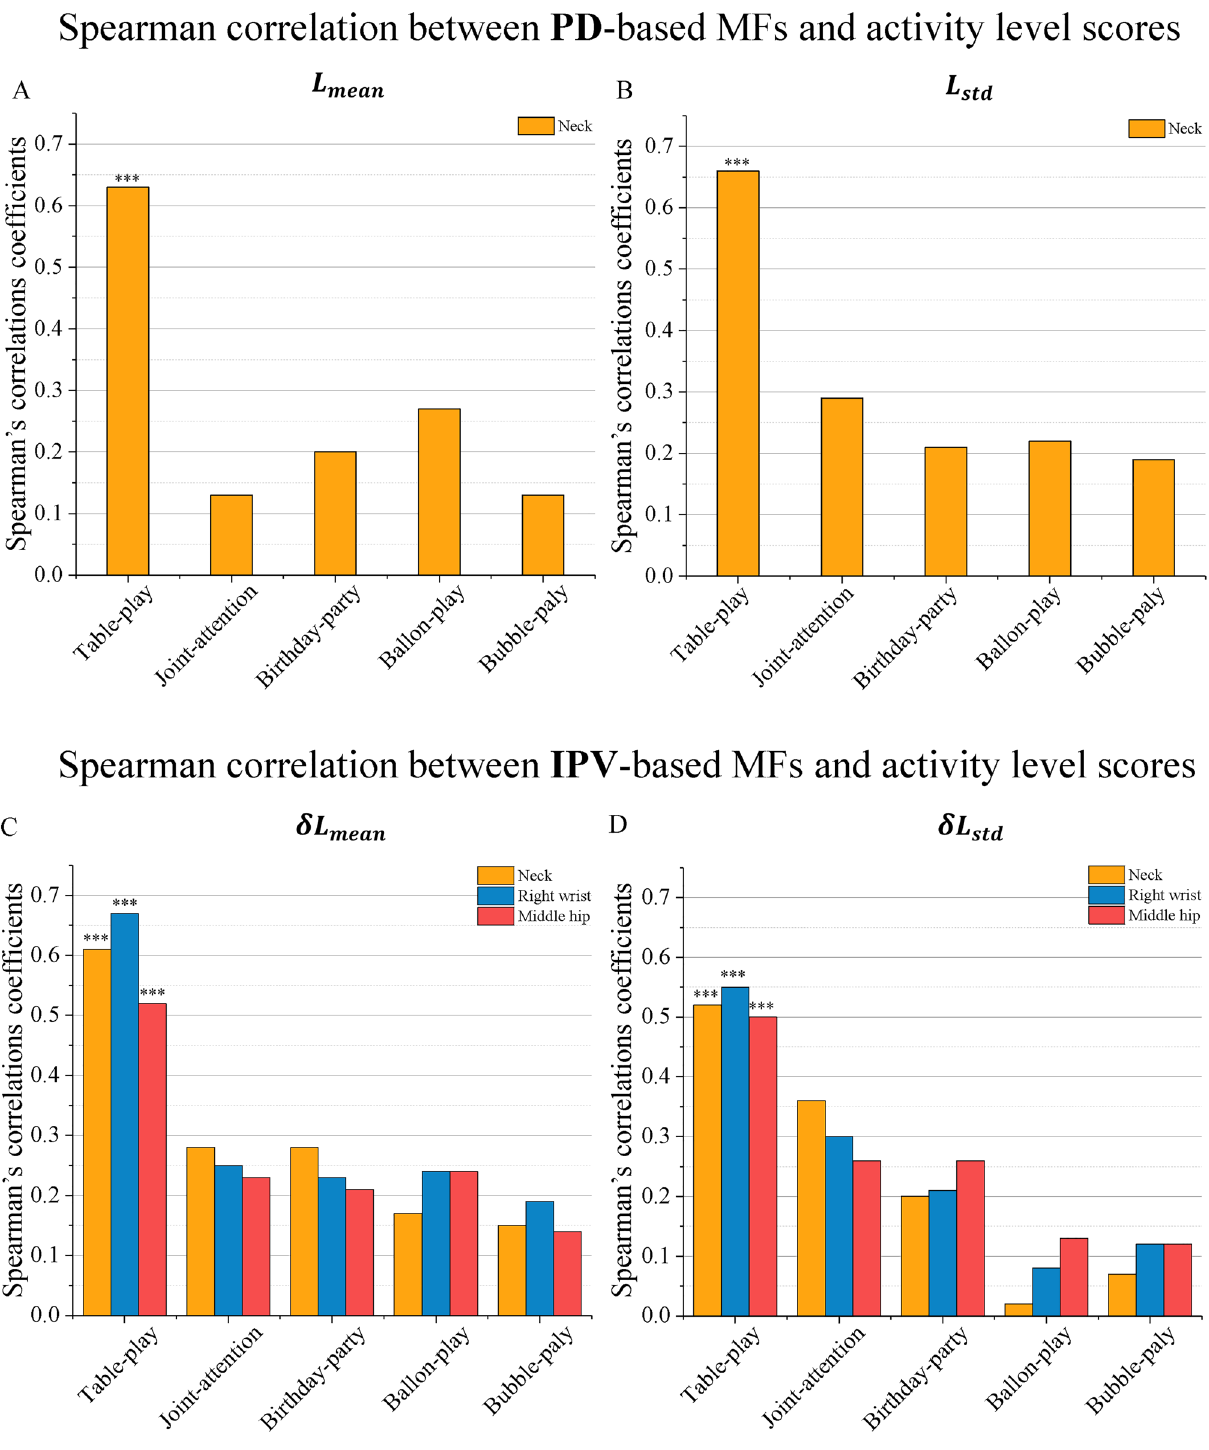
Figure 5. Spearman correlation coefficients between MFs and activity level scores evaluated by the clinicians for all five considered activities. Subfigure ( A , B ) showed the Spearman’s correlation coefficient (SCC) between PD-based movement features ( L mean & L std ) at neck key point and activity level scores; Subfigure ( C , D ) showed the SCC between IPV-based ( δ L mean & δ L std ) and activity level scores at three body key point (Neck, Right wrist, and Middle hip). * p < .05, ** p < .01, *** p <